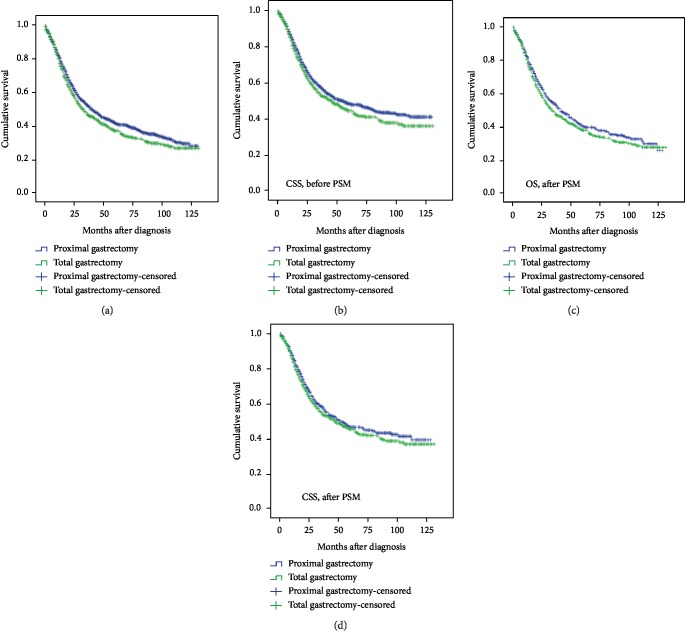
Survival comparisons in Siewert type II AEG patients between the PG group and the TG group. (a, b) OS (χ2 = 3.952, p = 0.047) and CSS (χ2 = 3.028, p = 0.073) before the PSM analysis. (c, d) OS (χ2 = 2.227, p = 0.136) and CSS (χ2 = 1.211, p = 0.271) after the PSM analysis.